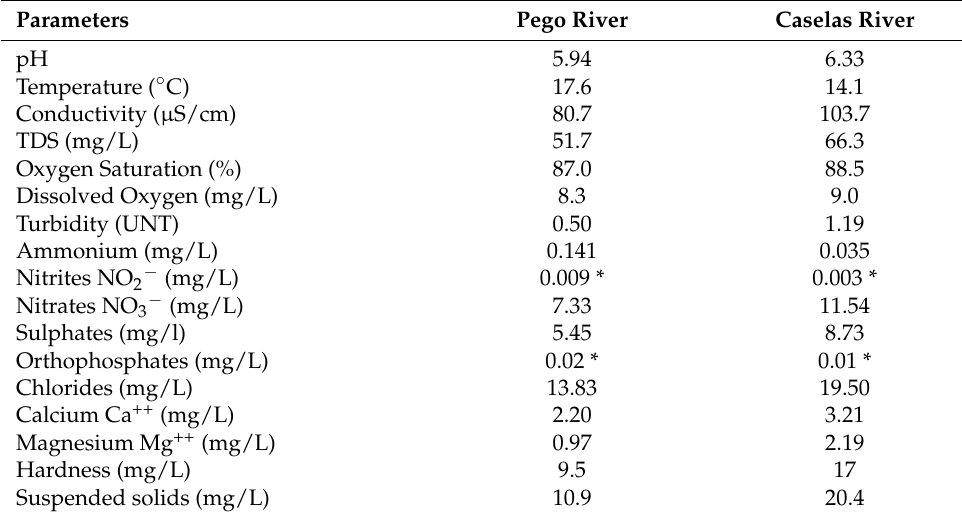
Table 1. Physicochemical parameters of the studied rivers. TDS: total dissolved solids. * Extrapolated data below the detection limit (LDD) LDD Nitrites: 0.035 mg/L; LDD Orthophosphates: 0.5 mg/L. Adapted from